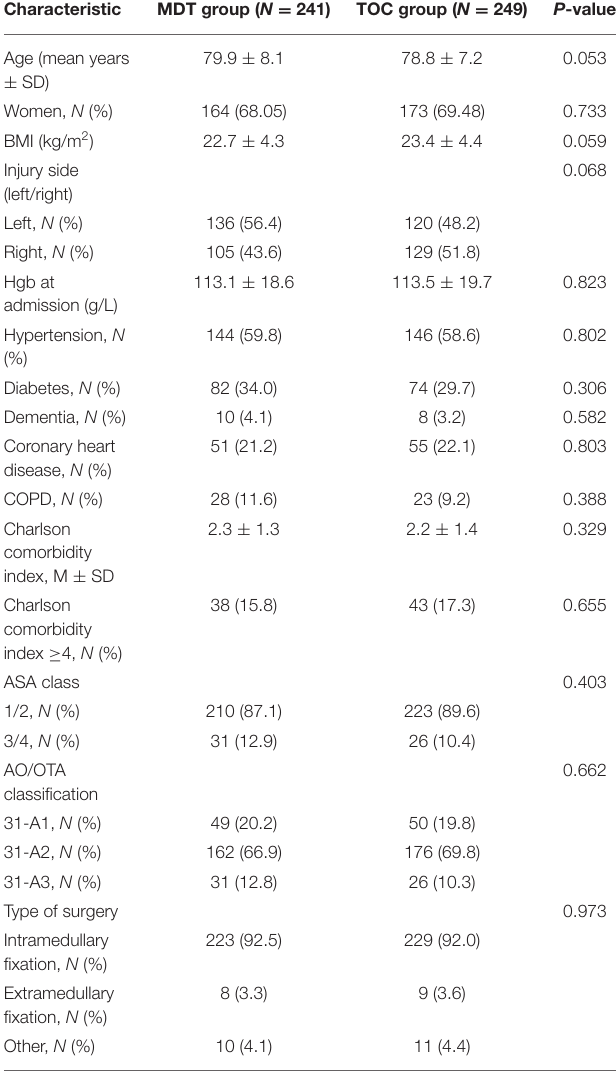
TABLE 1 | Baseline characteristics of the participants grouped by orthogeriatric co-management and orthopedic usual care.